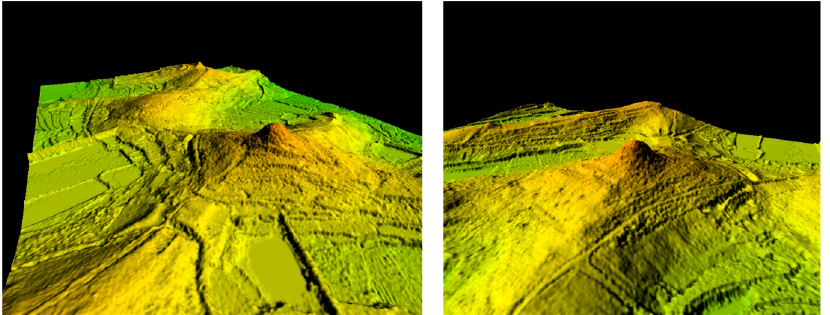
Figure 11. 3D views of the Lijia Tomb.